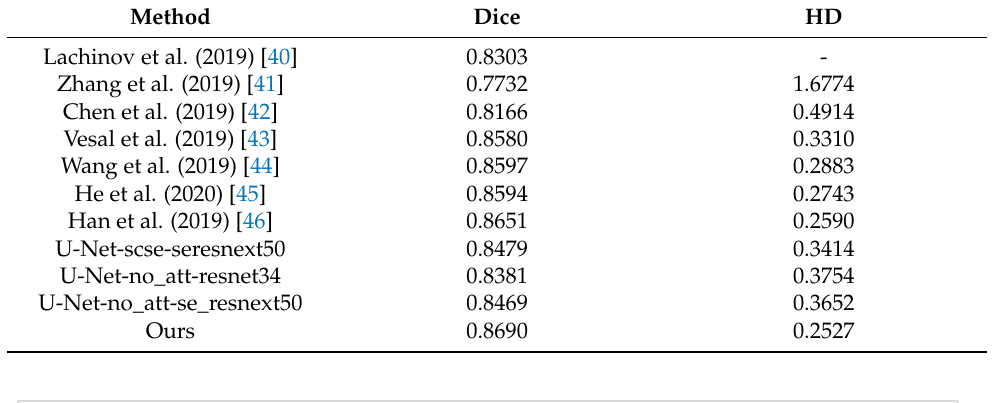
Table 1. Dice score and HD score of esophagus segmentation comparison between our proposed method with others in the test set of SegTHOR dataset. All values are computed by the online website https://competitions.codalab.org/competitions/21145 (accessed 28 May